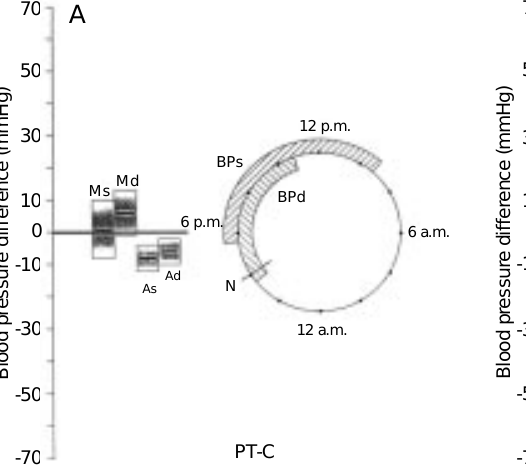
shown versus controls’ ac-